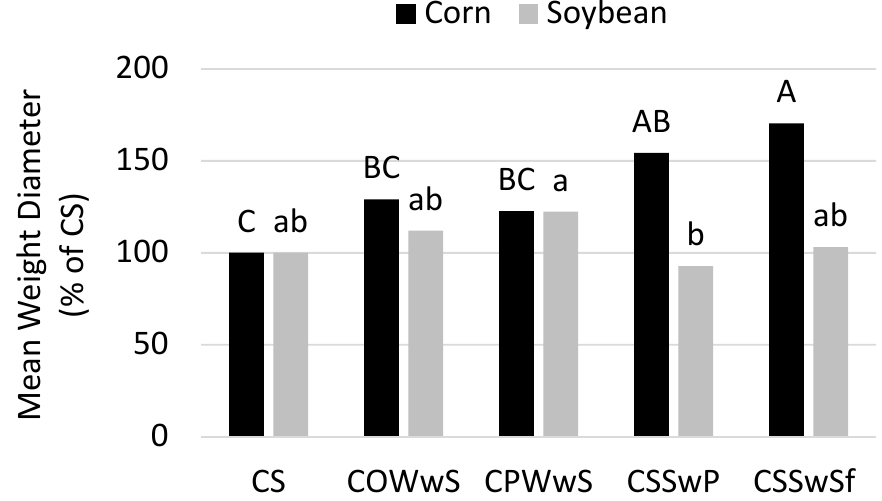
Figure 1. Mean weight diameter in the 0–5 cm depth interval; values are means ( n = 4) for each crop rotation treatment expressed a percentage of the mean for the default corn–soybean rotation according to crop phase. CS, corn–soybean; COWwS, corn–oat–winter wheat–soybean; CPWwS, corn–field pea–winter wheat–soybean; CSSwP, corn–soybean–spring wheat–field pea; CSSwSf, corn–soybean–spring wheat–sunflower. Values marked with the same letter within the aggregate group are not different at α = 0.05, Tukey’s test.